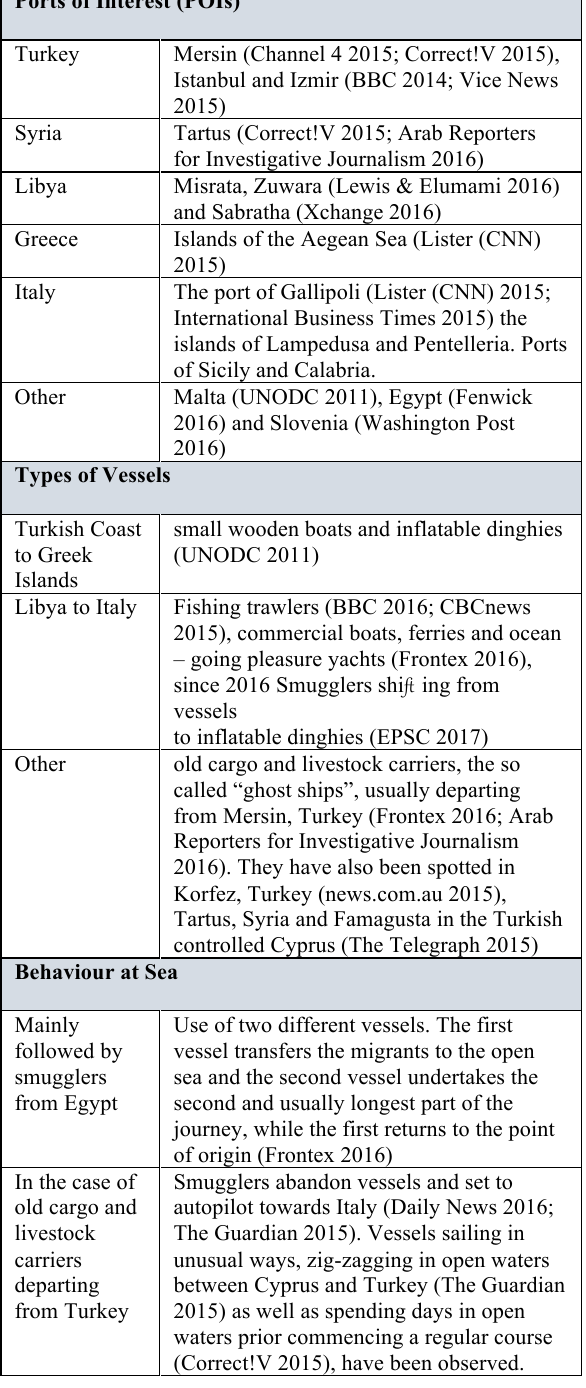
Table 1 . Summary of Migration Routes and Smuggling Tactics Ports of Interest (POIs)